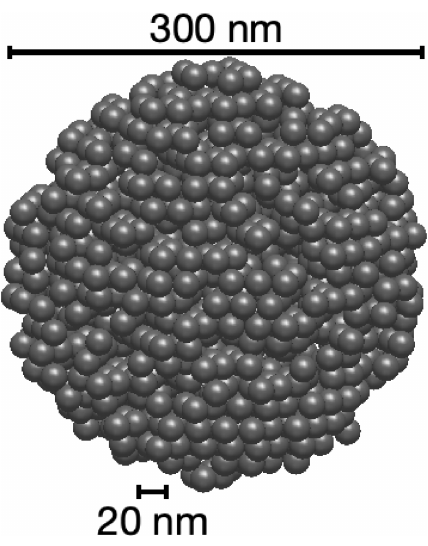
Figure 2. A model 300nm mobility diameter fullerene soot particle made by packing as many 20nm spherules as possible into a 320nm spherical region and then removing random spherules until the mass agreed with the formula in Gysel et al.